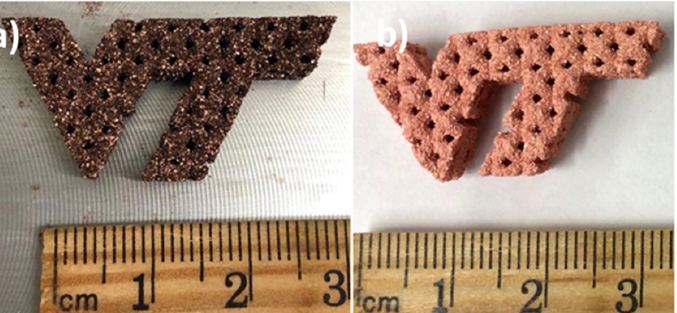
Figure 9. Copper foam part fabricated via AERO-Binder Jetting ( a ) green part ( b ) after sintering and annealing. Reproduced with permission from [99] Elsevier, 2020.